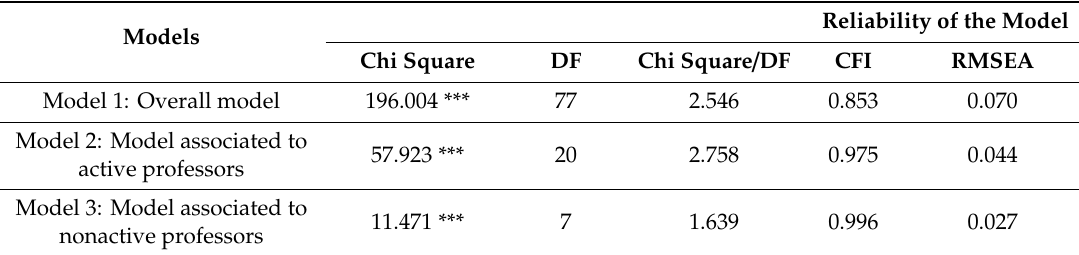
Table 6. Summary of the “model data